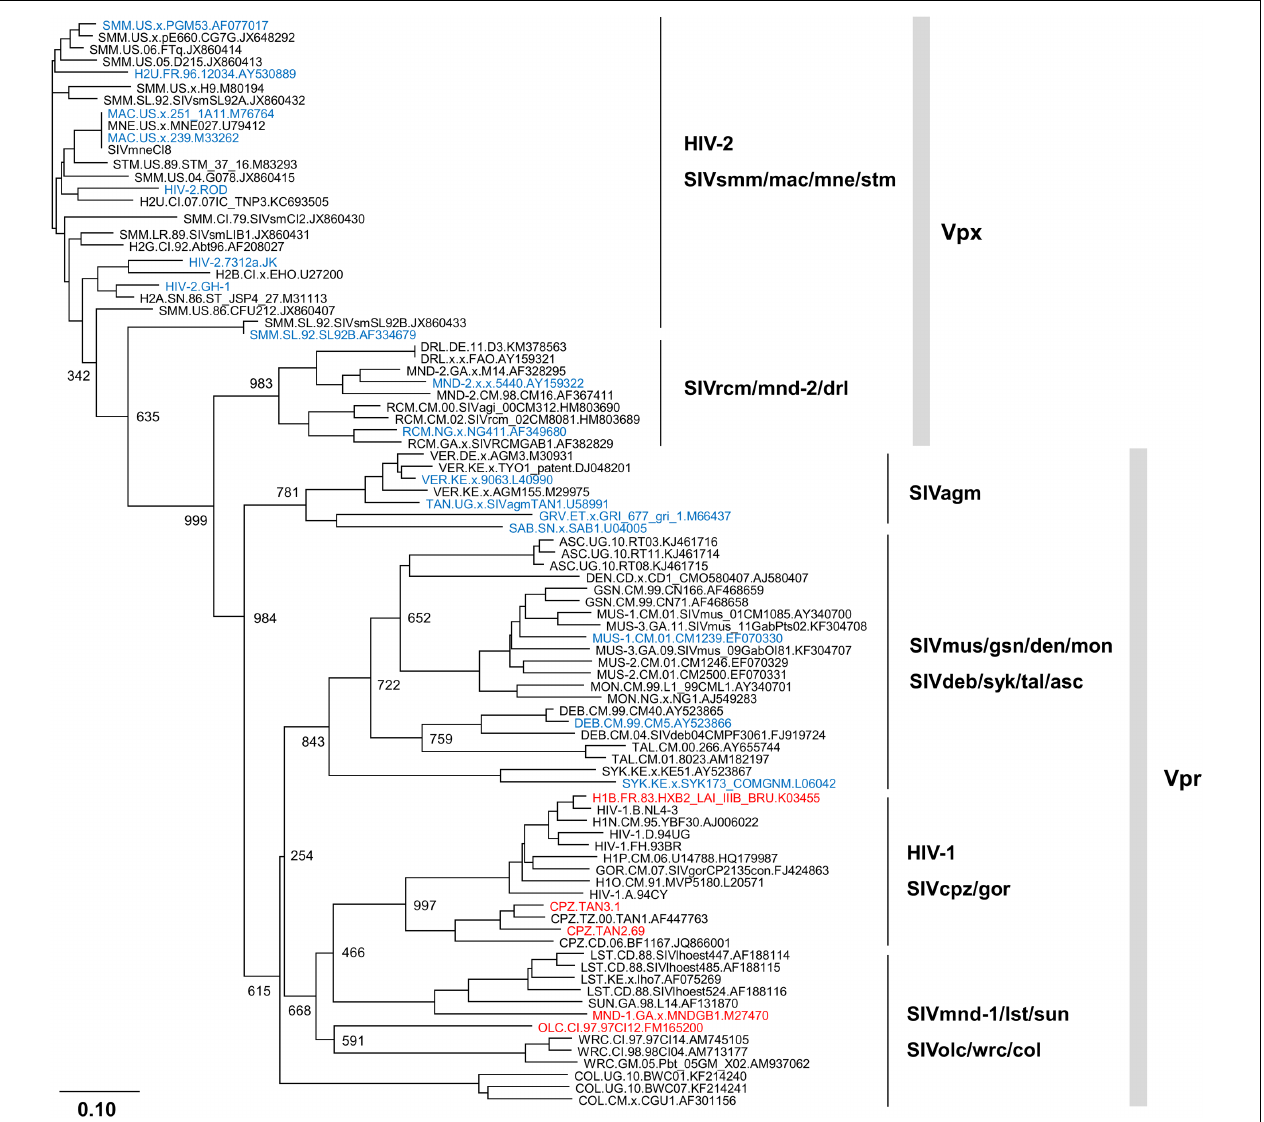
FIGURE 1 | Phylogeny of Vpx/Vpr proteins derived from various human immunodeficiency viruses/simian immunodeficiency viruses (HIV/SIVs). Phylogenetic tree based on diverse Vpx/Vpr proteins was constructed as previously described (Sakai et al., 2016), and is shown together with SAMHD1 (sterile alpha motif and HD-domain containing protein 1)-degrading activity. Viral clones with/without SAMHD1-degrading activity (Laguette et al., 2012; Lim et al., 2012) are indicated by blue and red letters, respectively. Note that Vpr proteins from HIV-2 type viruses (HIV-2, SIVsmm/mac/mne/stm, and SIVrcm/mnd-2/drl) are excluded from this tree for simplicity and clarity. Branches were calculated from 1000 bootstrap replicates, and the bootstrap values are labeled on the major branches. Scale bar represents the genetic distance. For virus designations, origins, and types, see the text (Introduction). Amino acid sequences were obtained from the HIV sequence database at Los Alamos National Laboratory (http://www.hiv.lanl.gov) or from the GenBank